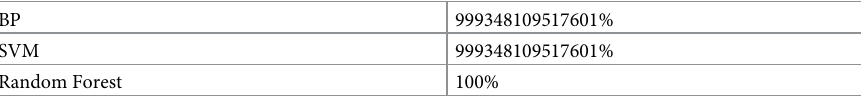
Table 7. Compared the BP model with competitive models.